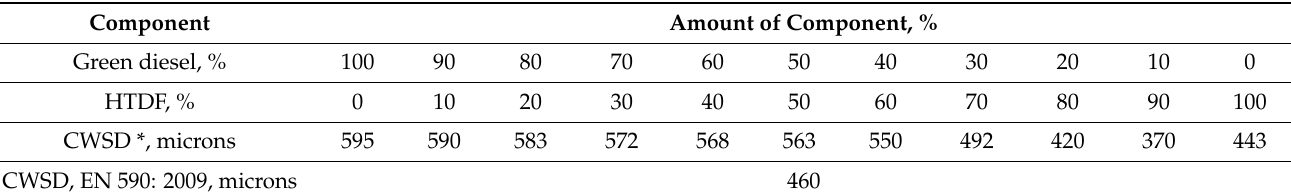
Table 4. Two-component superior diesel